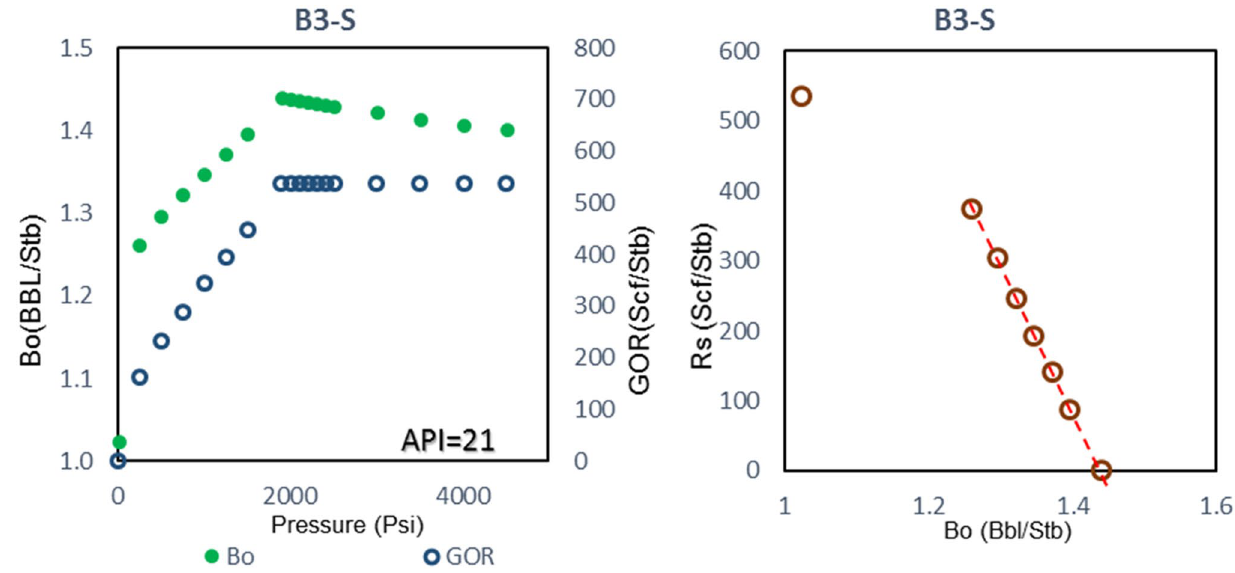
Fig. 6 GOR and Bo behavior of oil with API < 31-DL